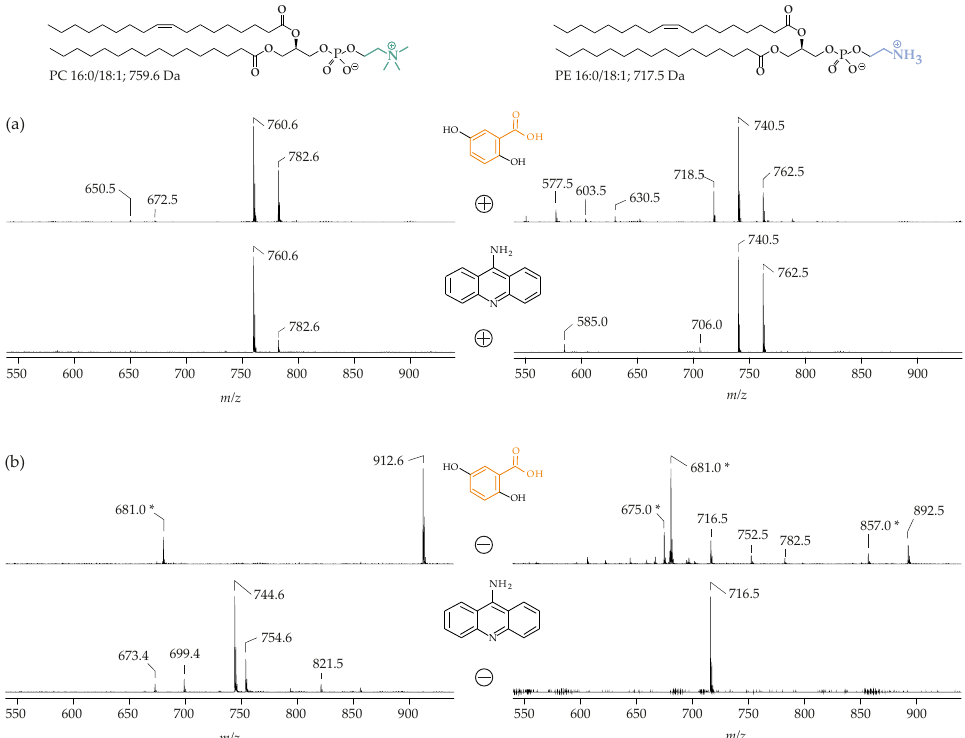
Figure 4. ( a ) Positive ion MALDI-TOF mass spectra of 1-palmitoyl-2-oleoyl- sn -phosphatidylcholine (PC 16:0/18:1; M = 759.6 g/mol, ( left )) and 1-palmitoyl-2-oleoyl- sn -phosphatidylethanolamine (PE 16:0/18:1; M = 717.5 g/mol; ( right )); ( b ) Negative ion MALDI-TOF mass spectra of PC 16:0/18:1 ( left ) and PE 16:0/18:1 ( right ). In all cases, the samples (0.2 mg/mL) were diluted 1:1 ( v / v ) either with a 2,5-dihydroxybenzoic acid (DHB; 0.5 M in methanol) or 9-aminoacridine (9-AA; 10 mg/mL in isopropanol/acetonitrile; 6/4, v / v ). All peaks are marked according to their m / z ratio. DHB matrix peaks are marked with asterisks. This figure was reprinted with permission from [96] and slightly